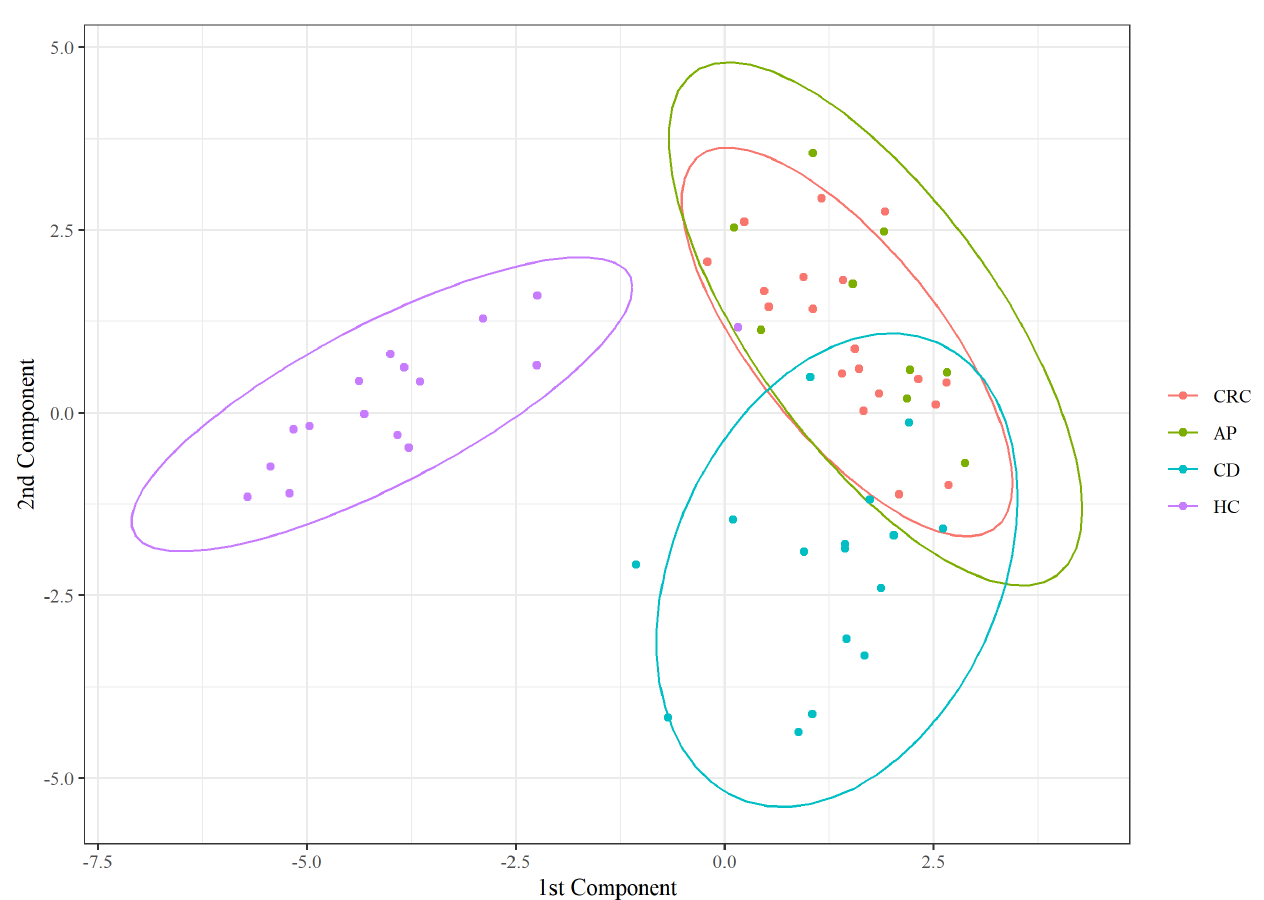
Figure 3. Partial least squares discriminant analysis (PLS − DA) score plot.